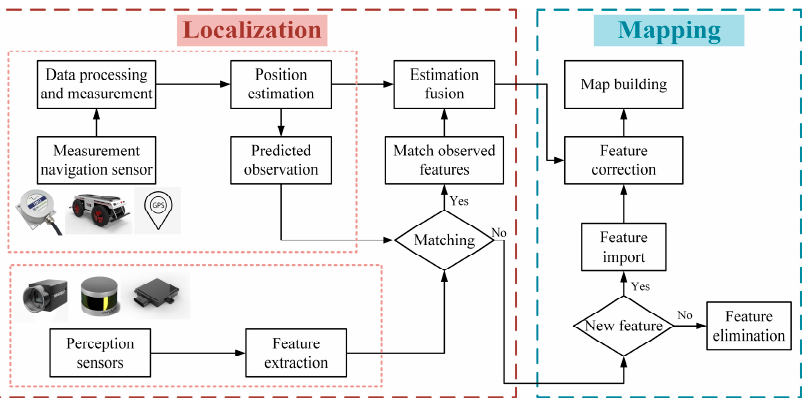
Figure 1. Feature-based fusion SLAM framework.